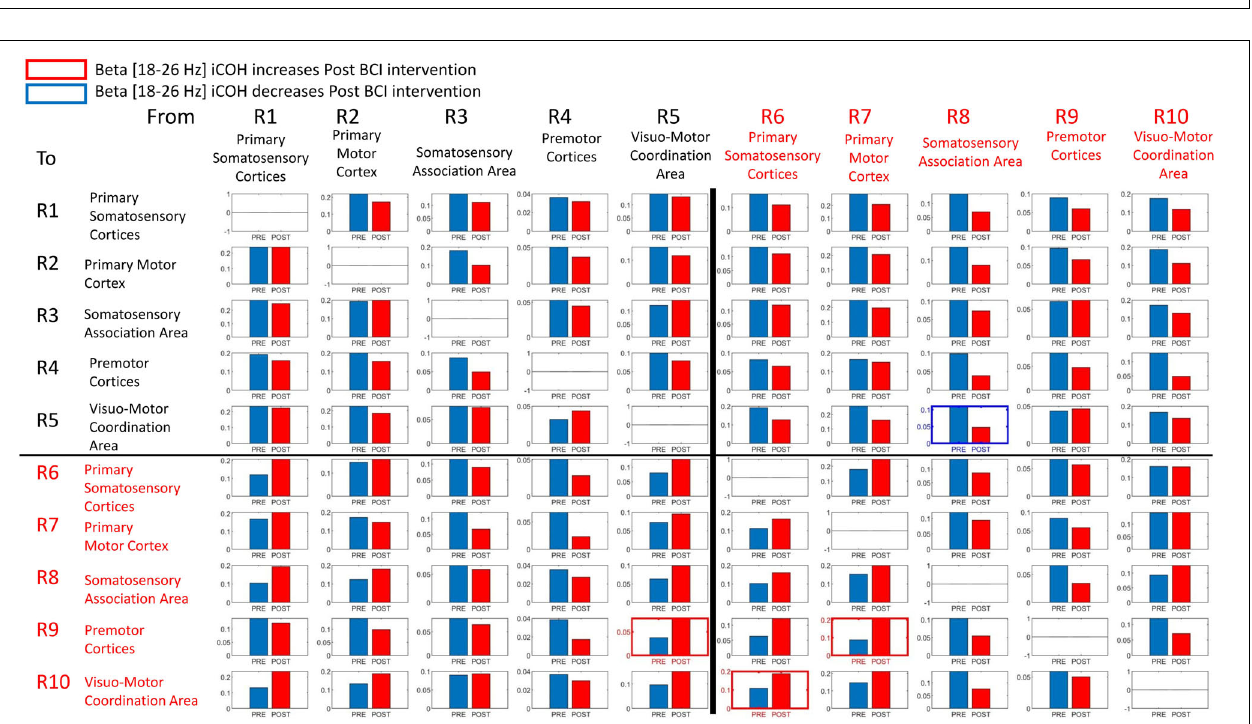
FIGURE 9 | Plots of iCoh between two given ROIs in the Beta frequency band [18–26 Hz], Pre and Post BCI intervention, Vertical axis: Coherence value –1 to 1. Horizontal axis: Pre (blue) and Post (red). Columns are senders, rows are receivers (i.e., FROM the top row of ROIs TO the horizontal columns of ROIs). Blue surrounding boxes indicate significant decrease in iCoh while red surrounding boxes denote significant increases in iCoh (Post vs. Pre).